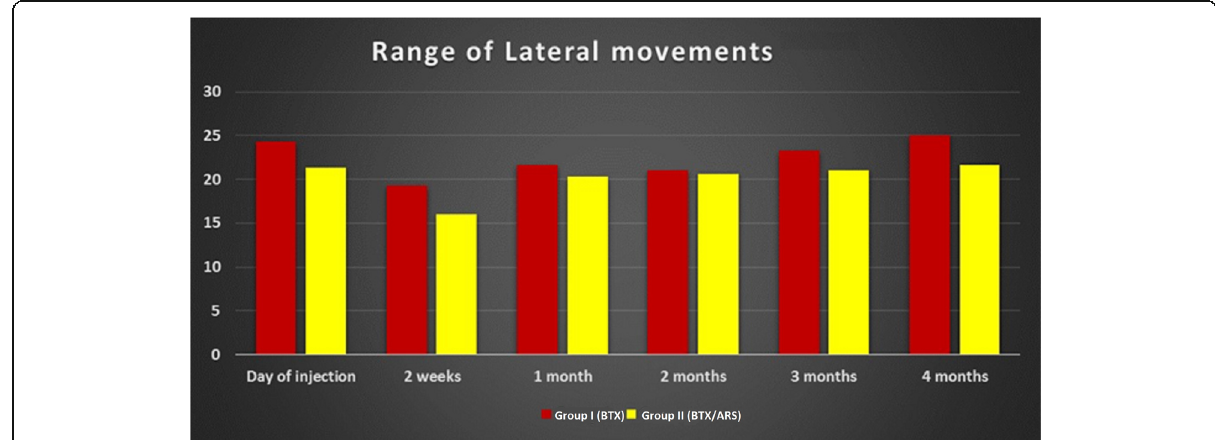
Fig. 5 Bar graph showing the lateral movement in millimetres along the study period in both groups